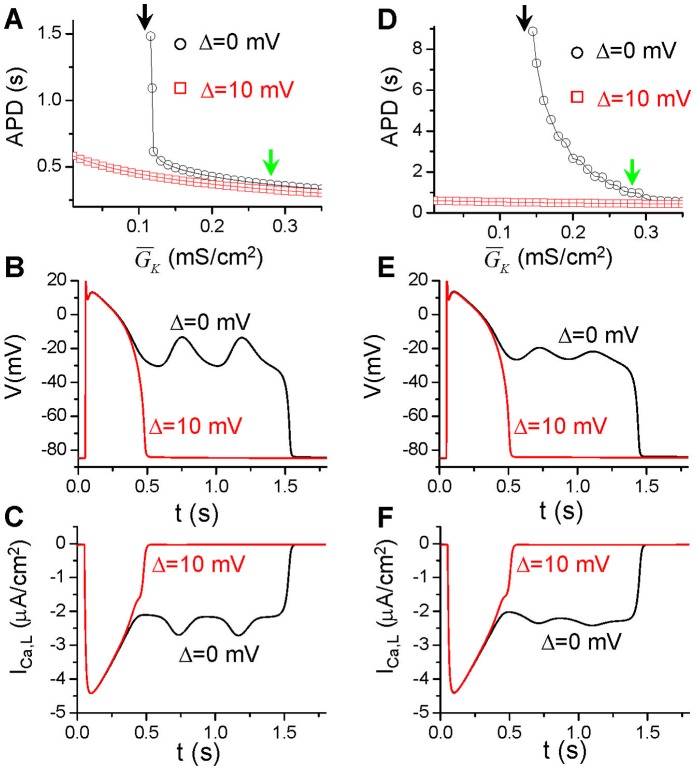
Effects of window ICa,L and activation speed of IK on APD.
A. APD vs  from the original LR1 model and from the one with 10 mV shift in f∞ (Δ = 10 mV). B. Two action potentials for  = 0.116 mS/cm2 in the original LR1 model and the one with 10 mV shift in f∞. C. ICa,L during the two action potentials in B. D-F. Same as A-C but for γ = 4.  = 0.25 mS/cm2 for E and F. Black arrows in A and D indicate that repolarization failure occurs when  is smaller than these values in the case of Δ = 0 mV (open circles). Green arrows indicate the control  (0.282 mS/cm2). The voltage was initially set to −84 mV with other variables close to their steady states. After 10 s (t = 0 in the plots), a single stimulus was given to elicit an action potential. The same stimulation protocol was used for Figures 4 and 5.